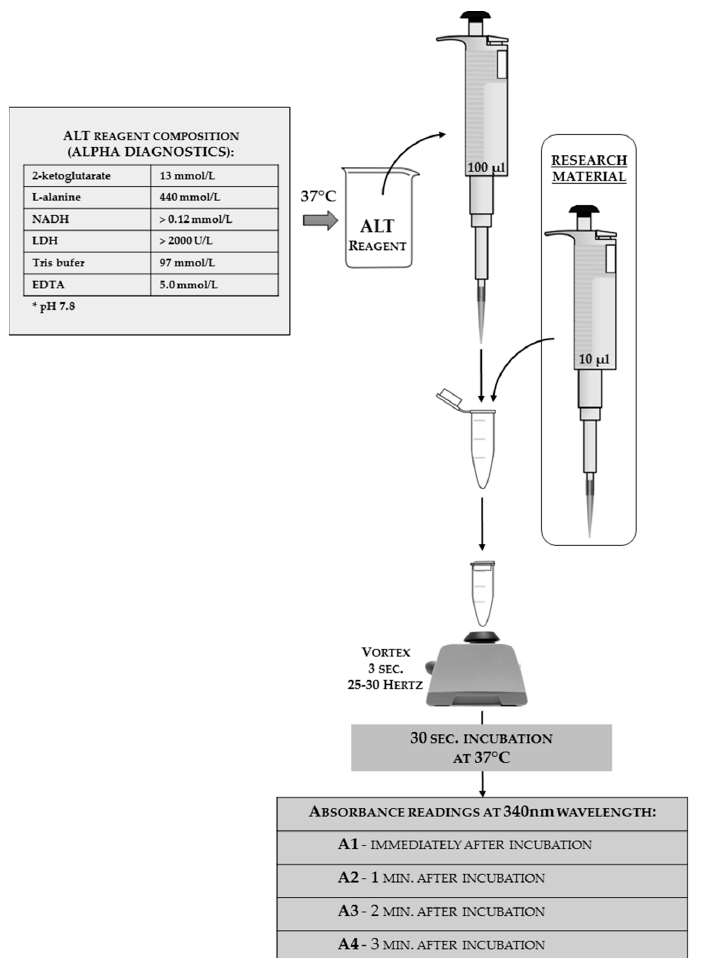
Figure 10. The scheme of alanine aminotransferase (ALT) activity analyses adjusted for insect hemolymph solutions with a one-reagent commercial kit from Alpha Diagnostics ® . The reagent composition declared by the manufacturer is shown on the left side of the scheme. The applied tools and reagents, along with the used volumes, are presented in the scheme.